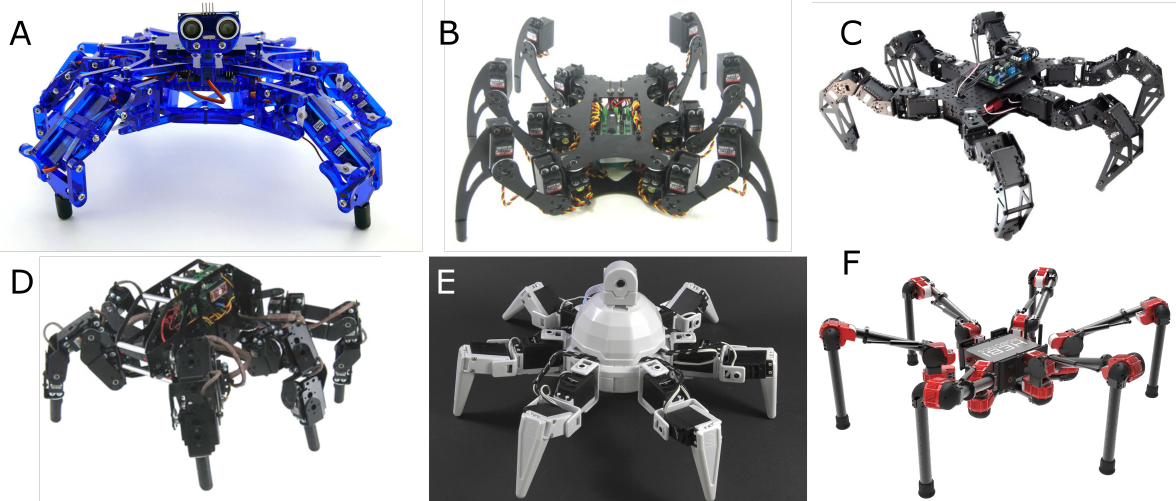
Figure 4. Open-source hexapod robots and educational robots available in kit form. ( A ) Hexy (Credits: ArcBotics). ( B ) Phoenix (Credits: Lynxmotion). ( C ) PhantomX (Credits: Interbotix Lab., Trossen Robotics). ( D ) T-Hex (Credits: Lynxmotion). ( E ) Six (Credits: EZ-Robot). ( F ) HEBI Robotics’ 18-DoF Daisy Hexapod, built using HEBI’s X-Series actuation hardware (Credits: ©HEBI Robotics